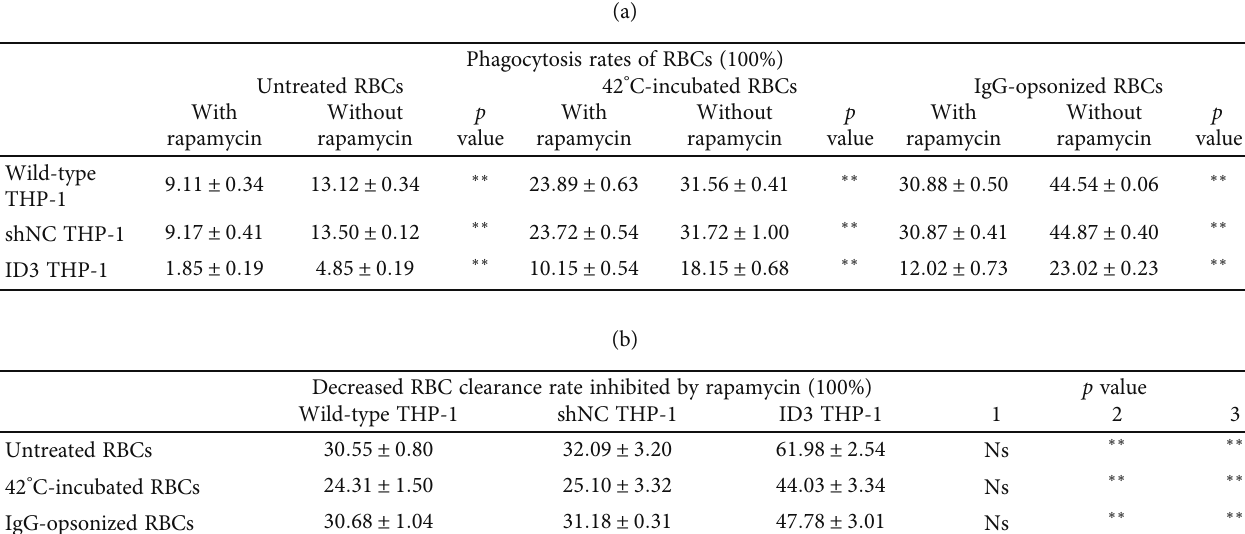
Table 3: Engulf ability of THP-1 cells to erythrocytes is inhibited using